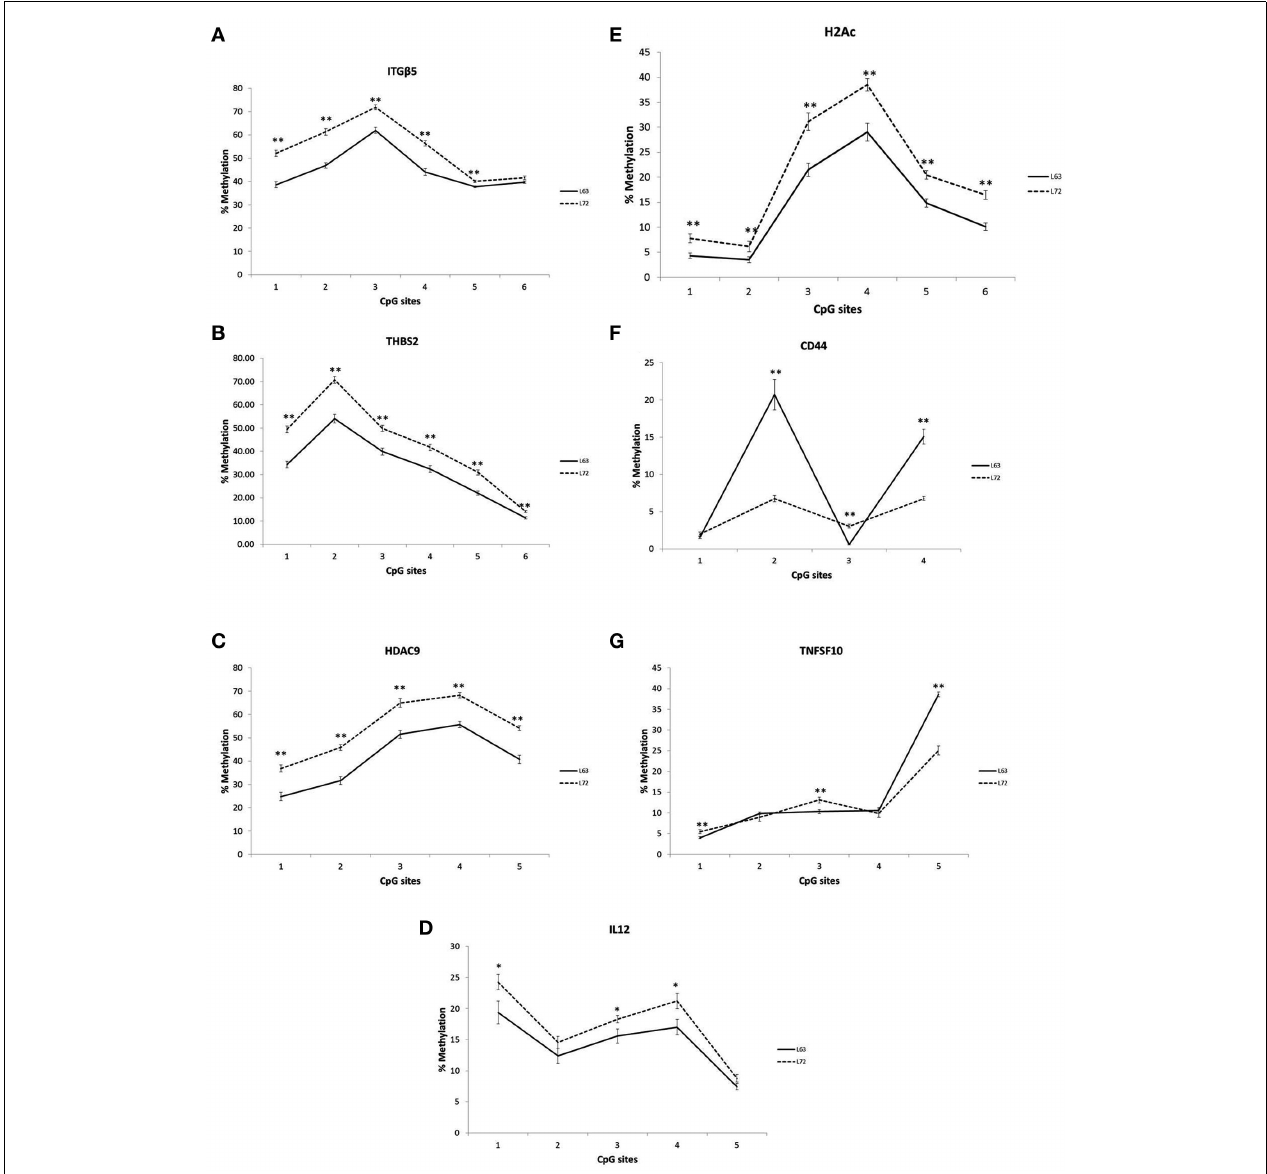
FIGURE 1 | Differentiated promoter methylation levels between the L6 3 and L7 2 chickens observed in ITG β 5 (A), THBS2 (B), HDAC9 (C), IL12 (D), H2Ac (E), CD44 (F), and TNFSF10 (G) . The promoter methylation levels of the genes in spleen were examined by pyrosequencing. The absolute methylation level for each CpG site from pyrosequencing result was plotted. Solid line: L6 3 ; dashed line: L7 2 . * P < 0.05, ** P < 0.01. N = 12 for each group. Error bar =